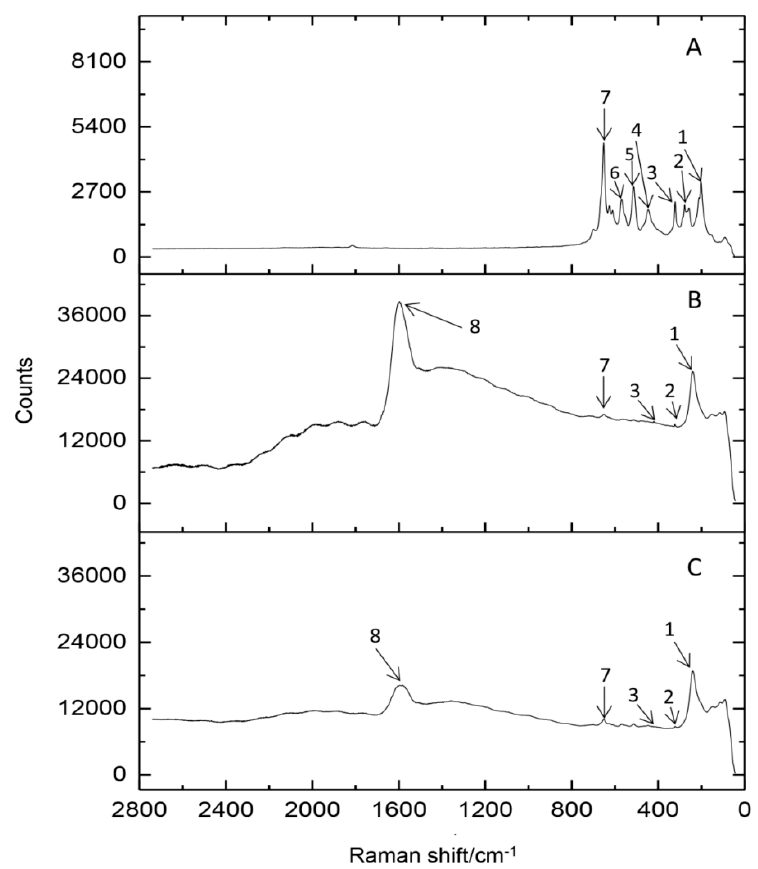
Figure 4. Raman spectra at the range 100–2800 cm − 1 for native casein ( A ) and after the process of silver cations binding depending on the conditions of uptake –in the light ( B ) and in the dark ( C ); Legend: (1) 231 cm − 1 , (2) 253 cm 1 , (3) 302 cm − 1 , (4) 433 cm − 1 , (5) 489 cm − 1 , (6) 551 cm − 1 , (7) 648 cm − 1 , (8) 1589 cm − 1 .